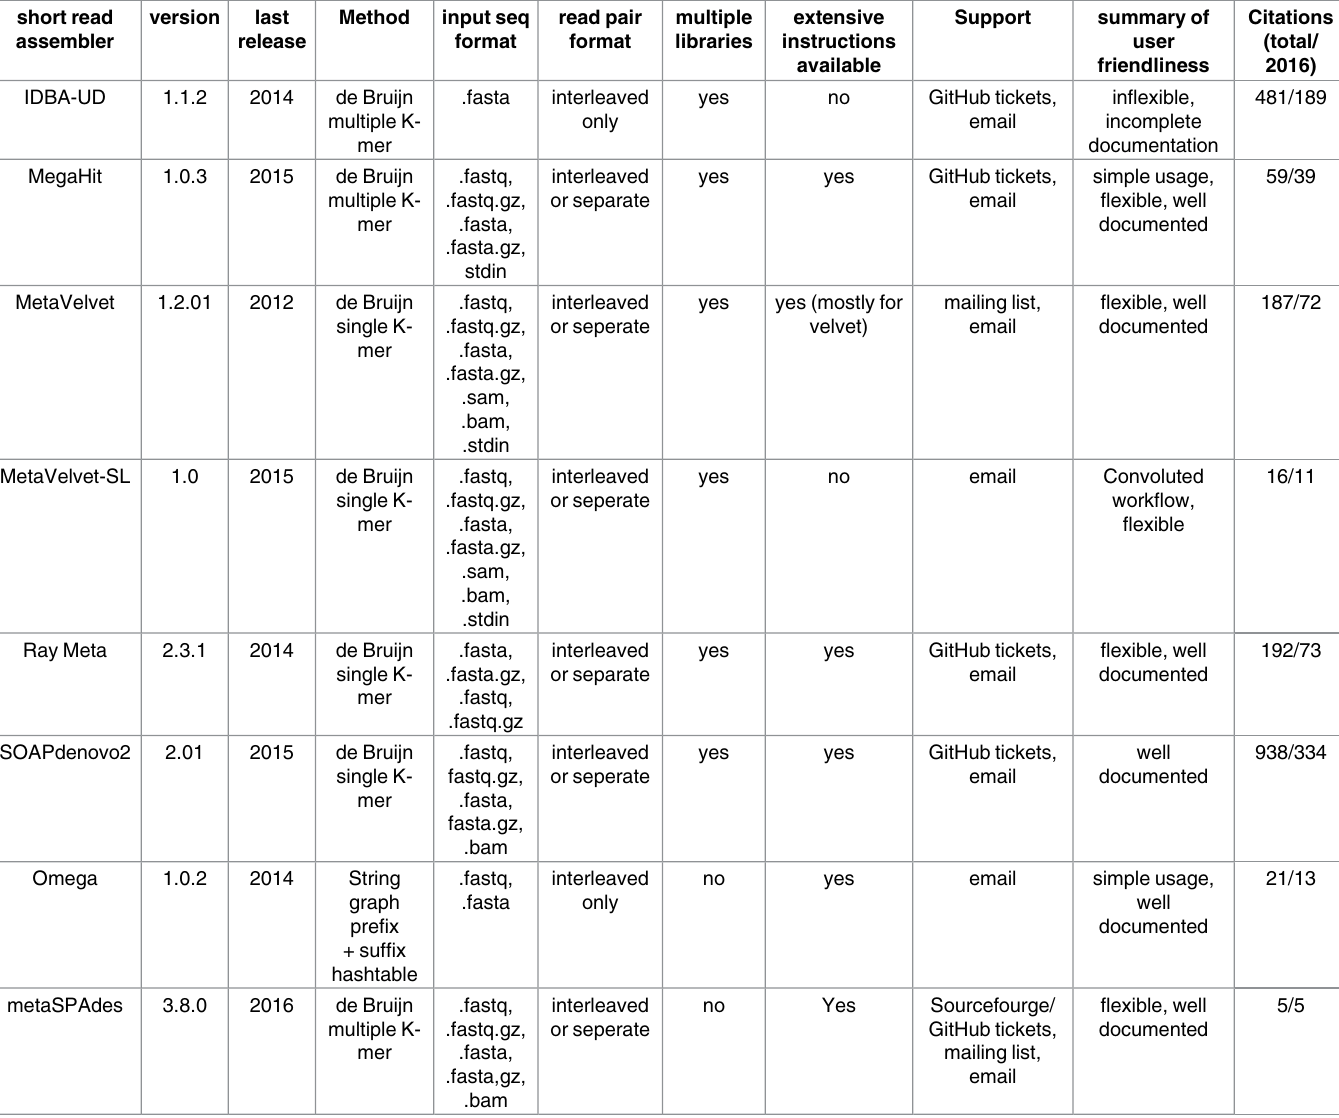
Table 1. Overview and basic characteristics of currently used and freely available short read metagenome assemblers. Included are basic charac- teristics influencingthe user friendliness, such as the rangeof acceptedinput formats or extent of documentation. The numberof total and recent citationsindi- cates the past and present popularityas well as dissemination of the respectivetool within the scientific